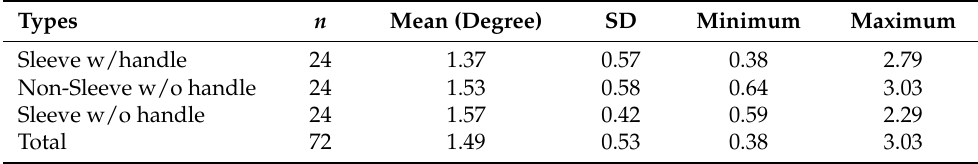
Table 2. Results of descriptive statistics of angular deviation in three types of surgical guides.